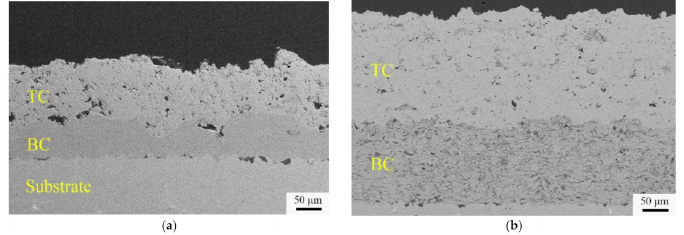
Figure 6. SEM morphology of different top coat thickness: ( a ) TBC on high pressure turbine; ( b ) TBC produced in the lab.